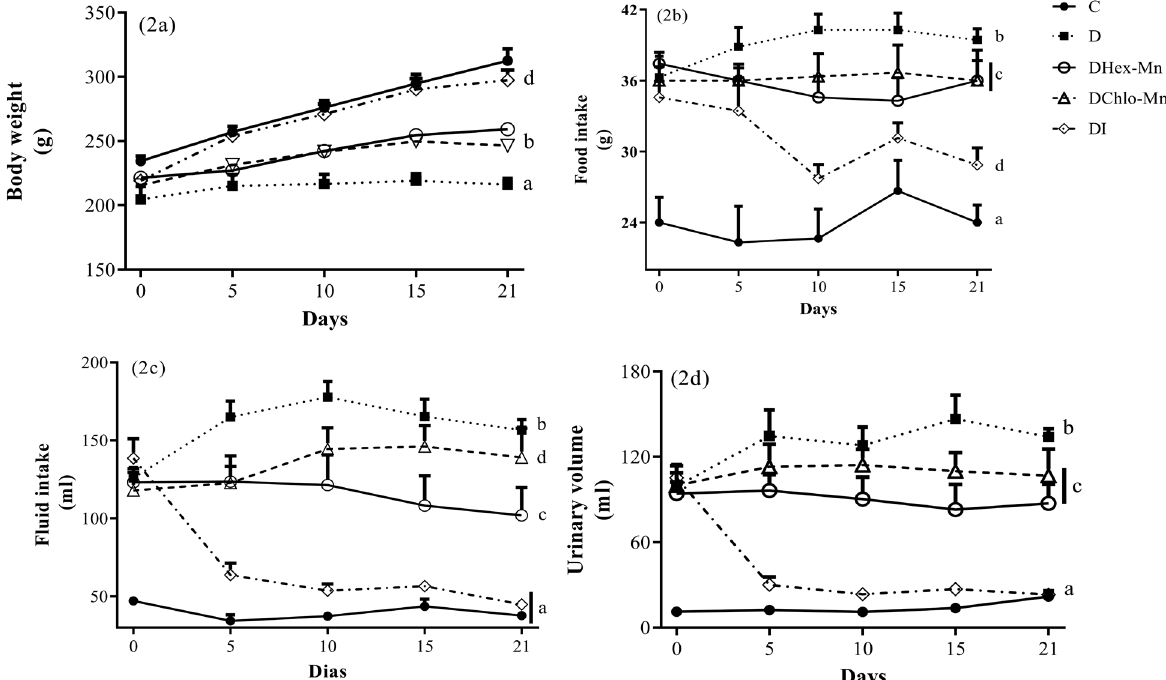
Figure 1. Effect of Hex-Mn and Chlor-Mn fractions on body weight (2a), food (2b) and fluid (2c) intake, urinary volume (2d) in control and STZ diabetic rats for 21-days treatment. Results are expressed as mean ± S.E.M. of 7 animals per